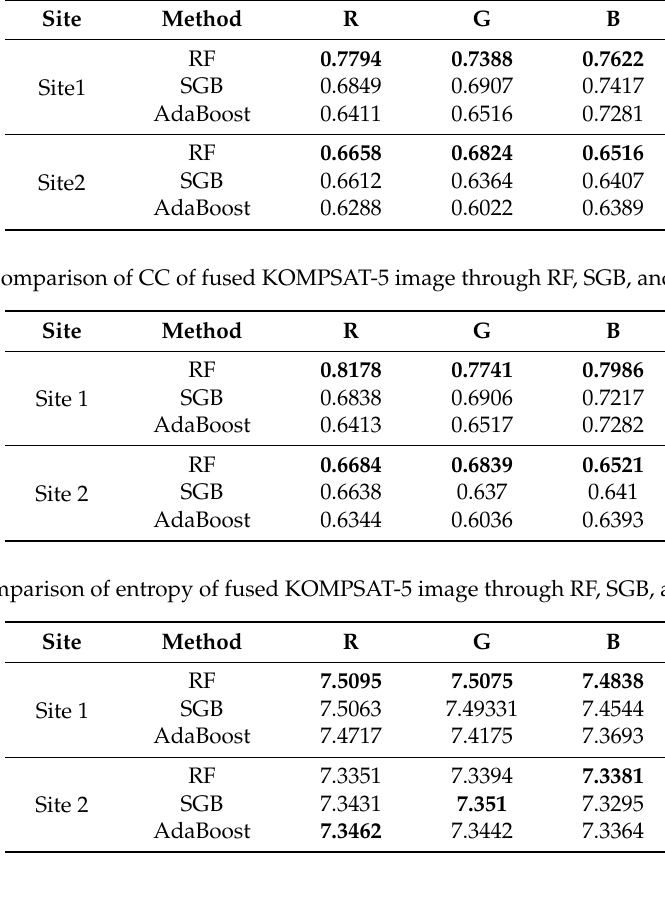
Table 6. Comparison of UIQI of fused KOMPSAT-5 image through RF, SGB, and AdaBoost.